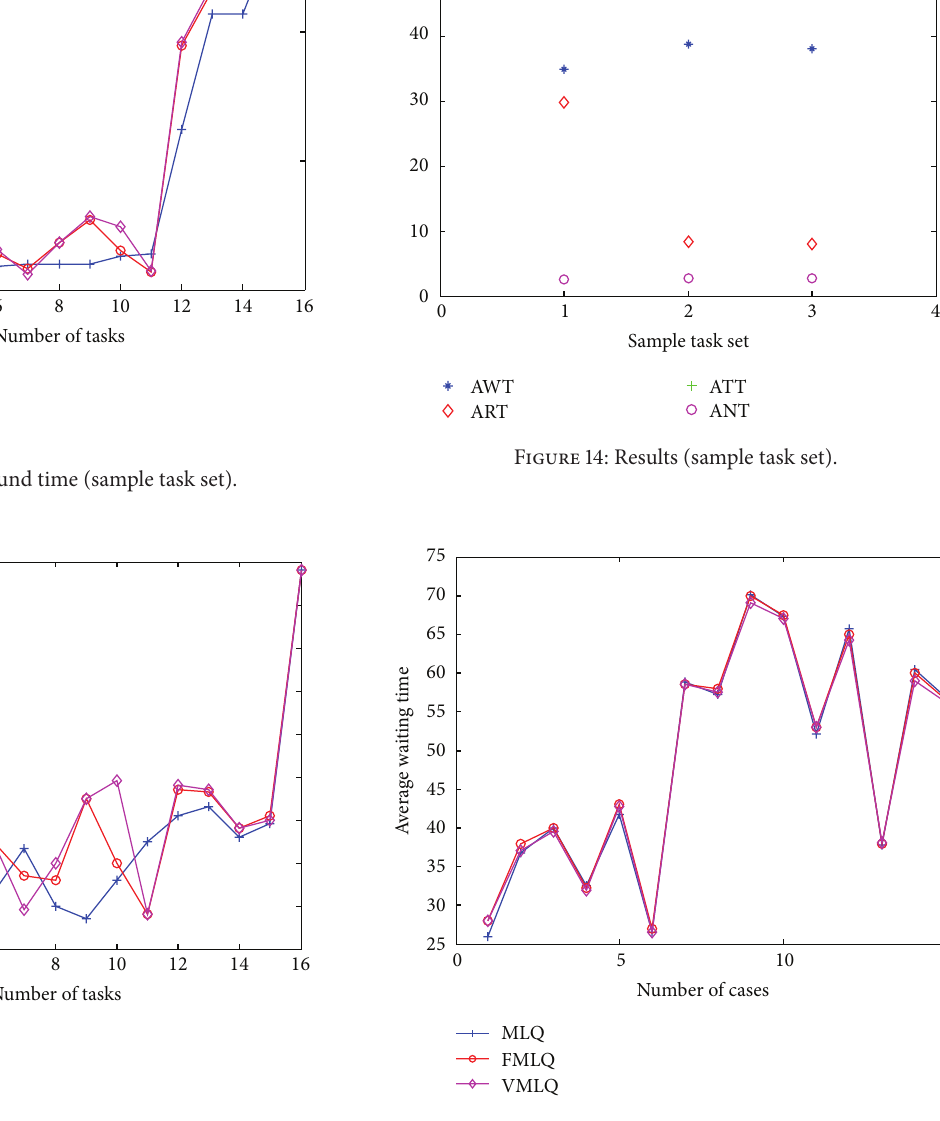
Figure 15: Average waiting